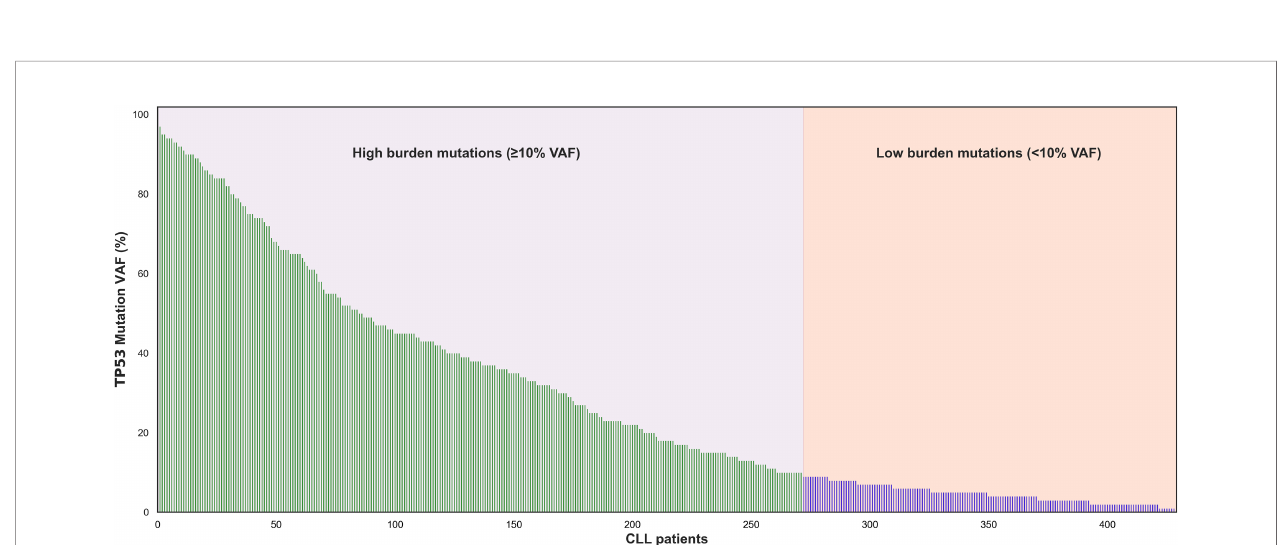
Frontiers in Oncology |